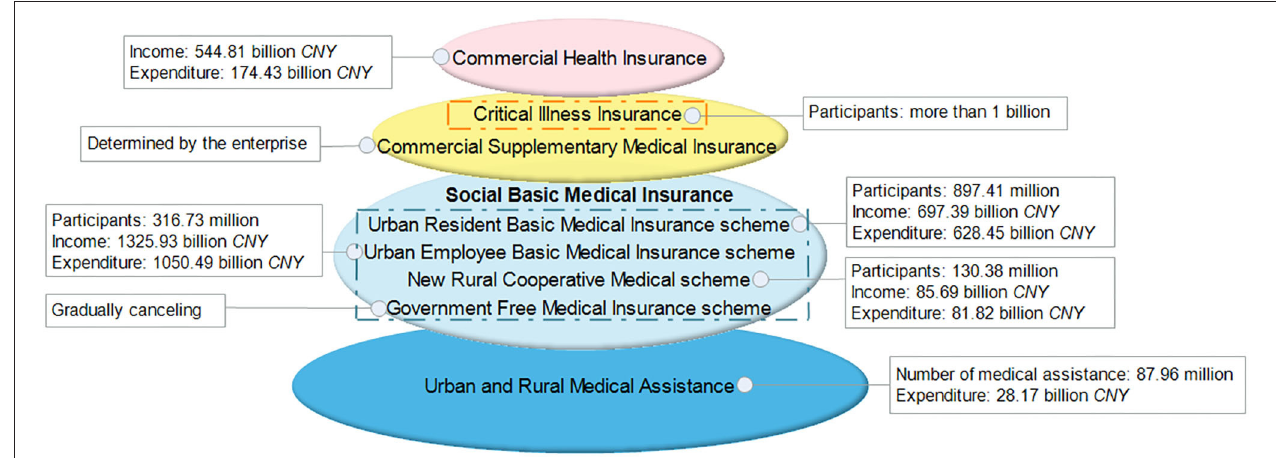
FIGURE 1 | China’s multilevel medical insurance system and its operation